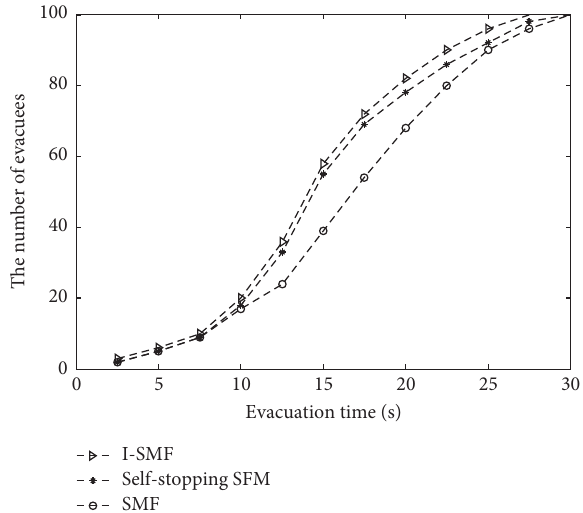
Figure 3: Contrastive analysis of the number of evacuees and evacuation